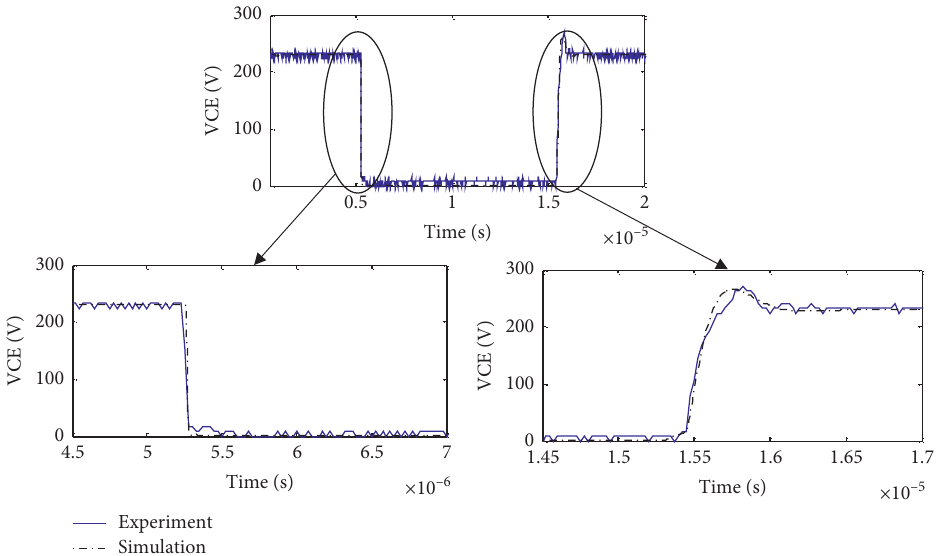
Figure 13: V CE waveforms of experimental and simulated dynamic IGBT (IRGBC20U)